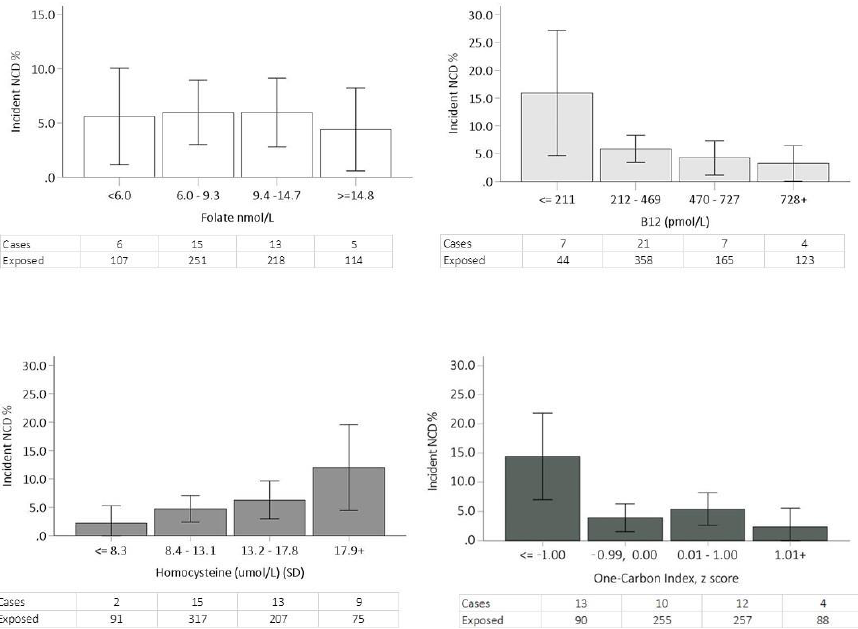
Figure 1. Number and % of incident neurocognitive disorder by SD quartiles of folate, B12, homocys- teine and one-carbon index. Logistic regression analysis. We estimated ORs of association of blood biomarkers with progression to NCD (Table 2) in logistic regression analysis. Lower per-SD levels of B12, one-carbon index and higher homocysteine were significantly associated with pro- gression to NCD in crude analyses. After adjustment for confounding co-variables, the association with NCD for lower levels of vitamin B12 (per-SD OR = 2.10, 95%CI = 1.26 – 3.52), for higher levels of homocysteine (per-SD OR = 1.96, 95%CI = 1.18 – 3.24), and for lower levels of one-carbon index (per-SD OR = 1.67, 95%CI = 1.06 – 2.64) remained signifi- cant. There was no significant association with progression to NCD for folate level. Low B12-high folate (versus normal folate-and-normal B12) was significantly associated with progression to NCD in the unadjusted model (OR = 4.80 (95%CI = 1.49 – 15.5), and after adjustment for confounding co-variables (OR = 3.81 (95%CI = 1.04 – 13.9). Table 2. Associations of B12, folate and homocysteine with incident NCD.